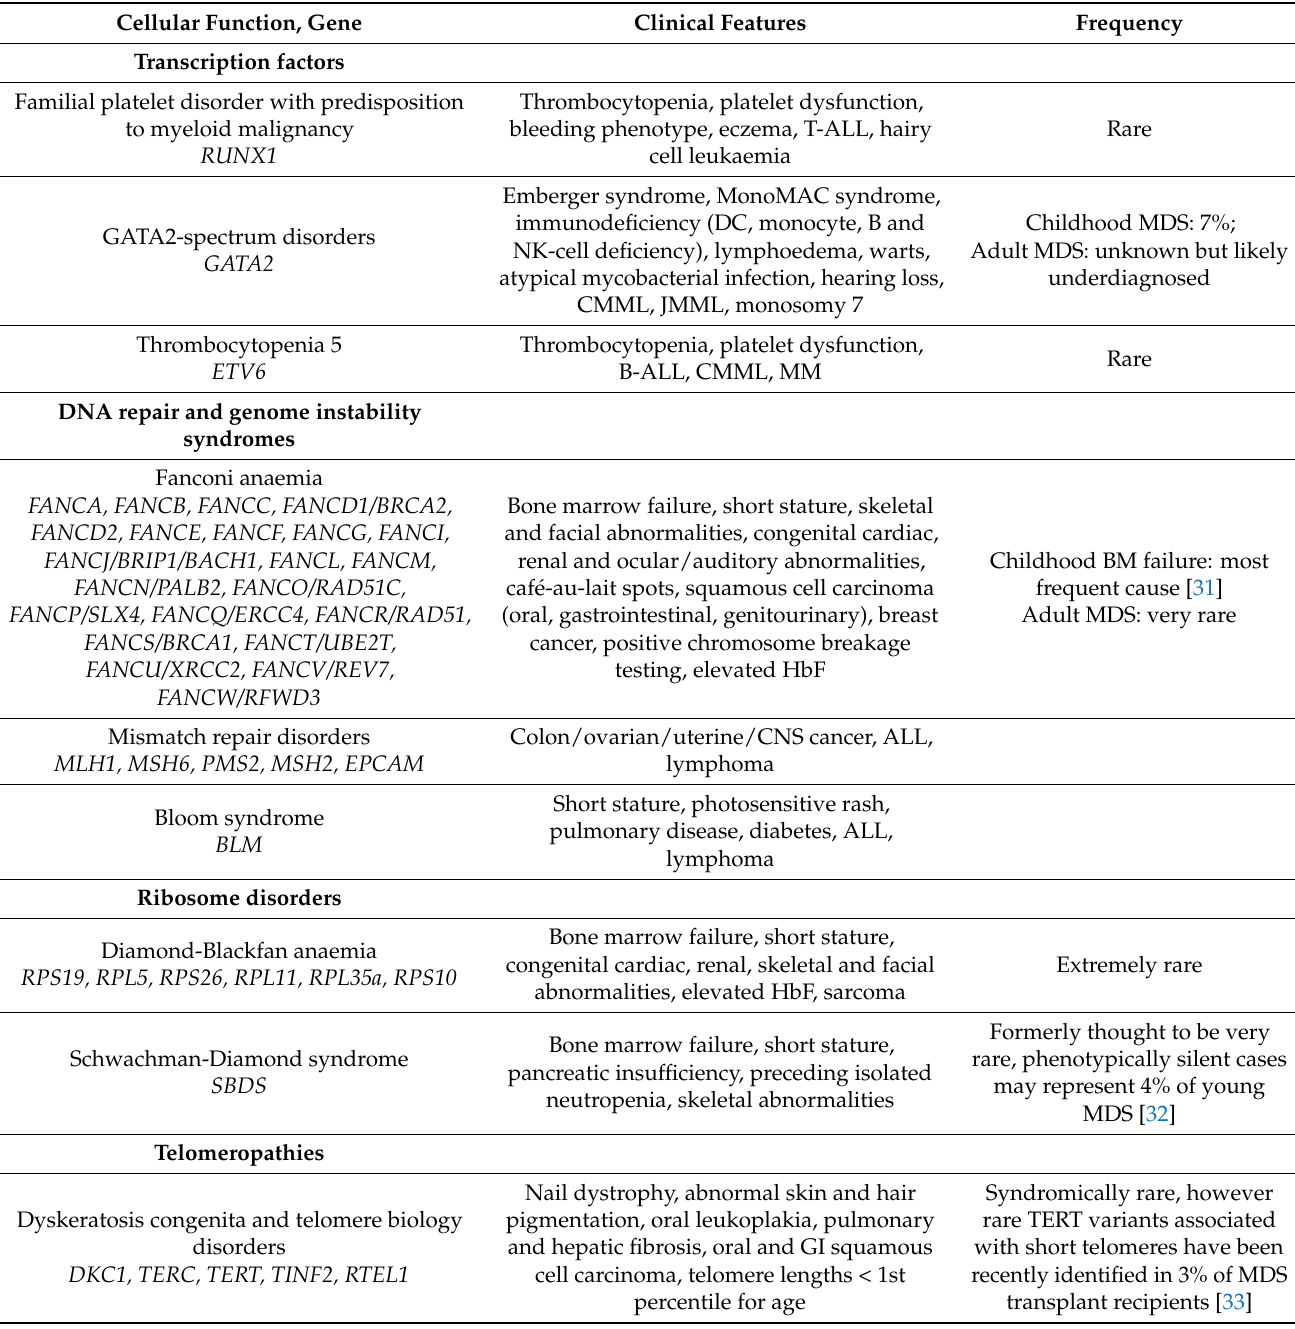
Table 1. Selected genes involved in germline MDS predisposition and associated